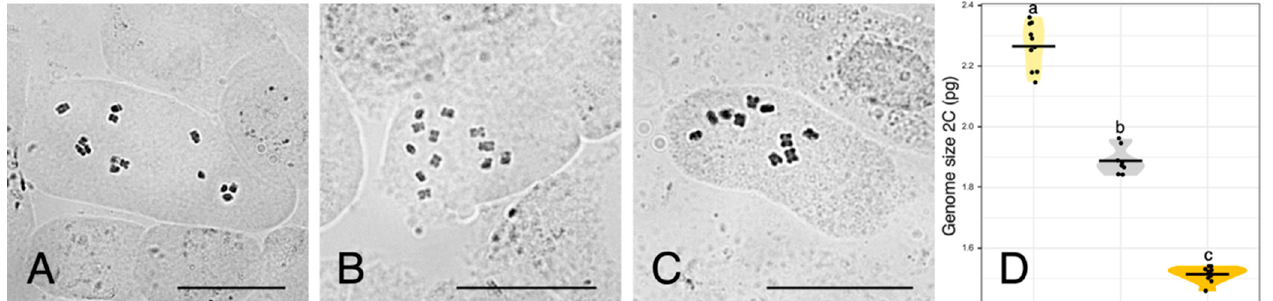
Figure 2. ( A – C ) Somatic metaphase plates of Urospermum dalechampii , 2n = 14 ( A ), U. dalechampii × U. picroides , 2n = 12 ( B ), and U. picroides , 2n = 10 ( C ). Scale bars = 10 μ m. ( D ) Violin plots showing the distribution of genome size in U. dalechampii (yellow), U. dalechampii × U. picroides (grey) and U. picroides (orange). Horizontal lines of violin plots represent mean values for the variables, and dots represent values for each individual. Letters above violins indicate which groups are statistically different from one another.